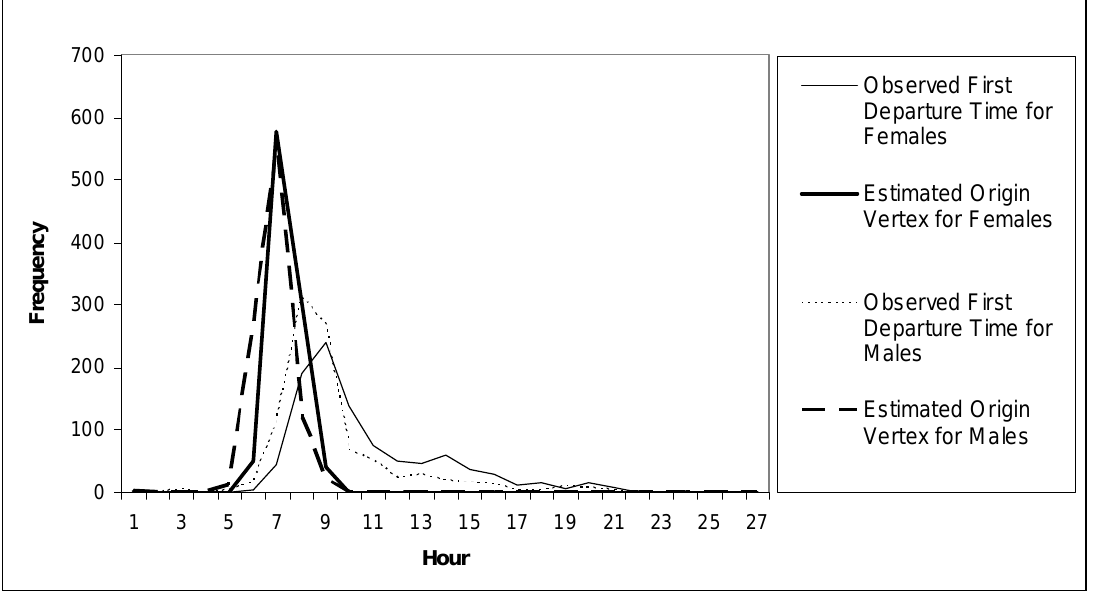
Figure 2. Distribution of estimated origin vertex location and first departure from home for females and males Table 3. Stochastic Frontier Models for the Origin Vertex Female Male Variable Coef. t -stat